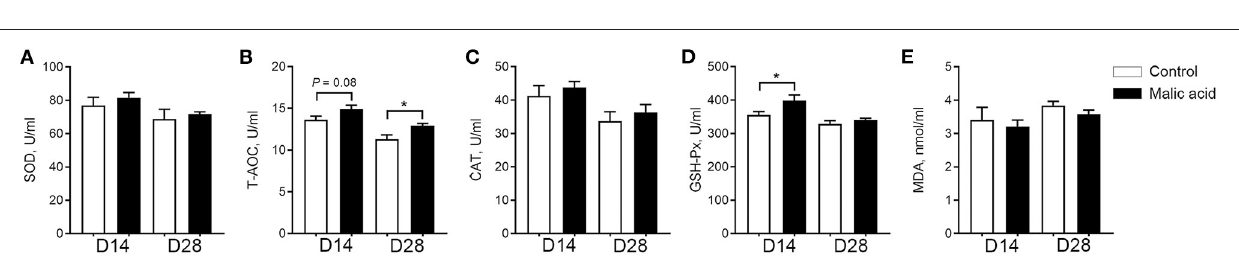
FIGURE 3 | Effects of dietary malic acid supplementation on antioxidant capacity of weaned piglets. Activities of (A) SOD, (B) T-AOC, (C) CAT, (D) GSH-Px, and level of (E) MDA in serum on days 14 and 28 of the experiment. Data are presented as means ± SEM ( n = 6). The statistical significance of difference between two means was calculated using t -test. * p <